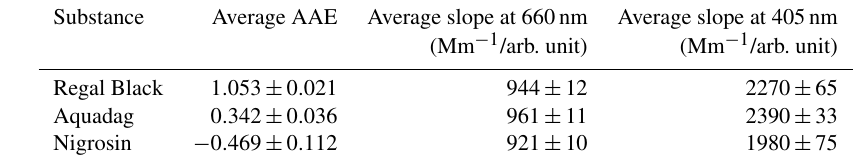
Table 1. Summary of AAE and calibration slopes for each substance, reported as average and standard deviation from six calibrations.